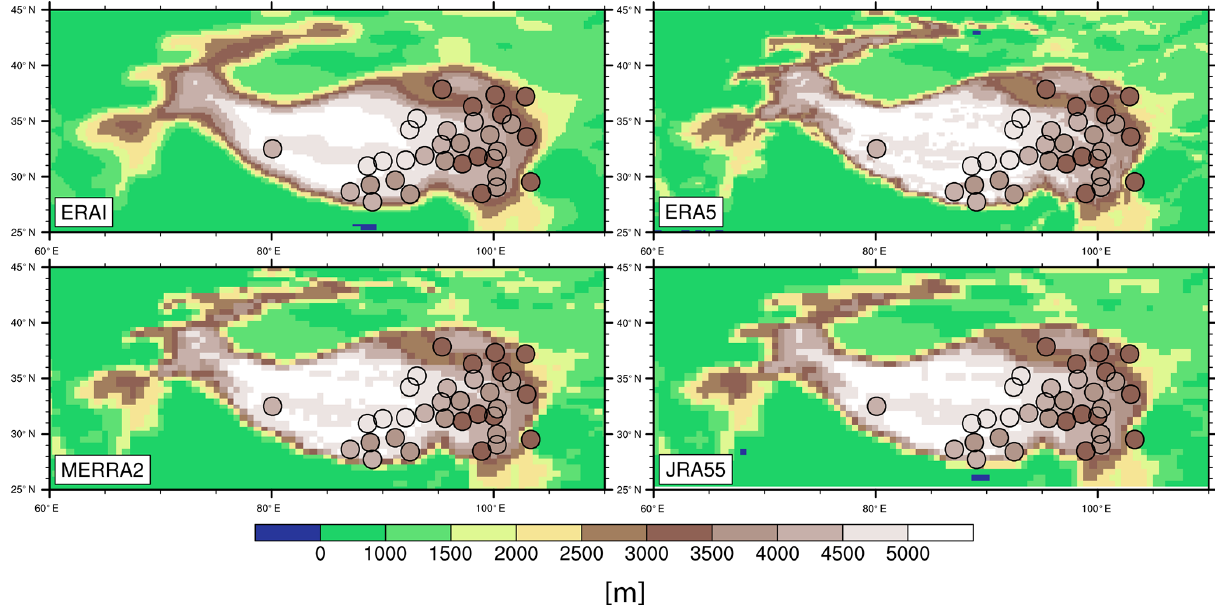
Figure 1. Topographic maps of the TP region (altitude in metres) at the horizontal resolution of each reanalysis. The locations of the 33 stations are also shown with the coloured circles indicating the altitude range. Table 1. General characteristics of the